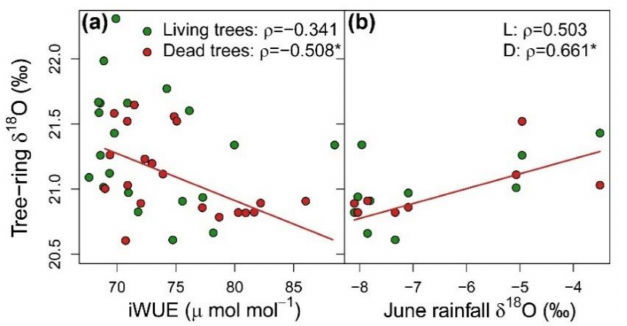
Figure 3. Relationships between tree ring oxygen isotopic ratio ( δ 18 O) and ( a ) intrinsic water-use efficiency (iWUE), and ( b ) rainfall δ 18 O in June for the period 1964–2017 in living trees (L; green symbols) and dead trees (D; red lines and symbols) of Nothofagus dombeyi . Values correspond to groups of five consecutive rings pooled at vigor-class level. Spearman ρ statistic and associated p -value (* p < 0.05) are indicated in each graph for correlations at vigor class level. Significant correlations are highlighted with lines.